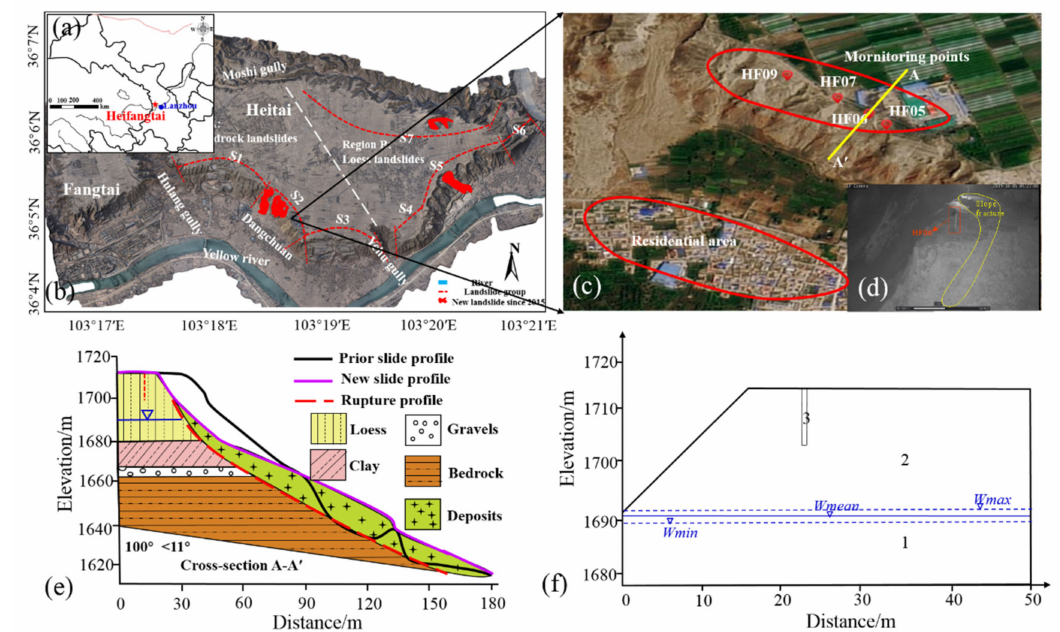
Figure 10. ( a ) Location of the study region (red star); ( b ) aerial view of the Heifangtai with landslide sections (image photo on 18 January 2015) [61]; ( c ) distribution of monitoring points and residential area; ( d ) monitored slope fracture in HF06; ( e ) lithological profile of cross-section A-A (cid:48) ; ( f ) geometric profile of the cross-section A-A (cid:48) (1 denotes saturated loess, 2 denotes unsaturated loess, 3 denotes the crack).